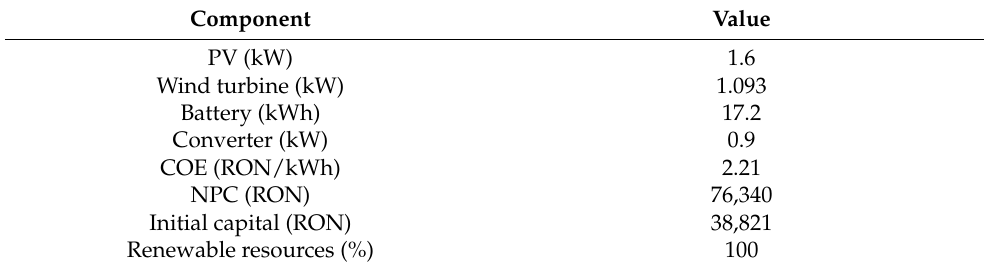
Table 13. The simulation results for the third case using iHOGA simulator.